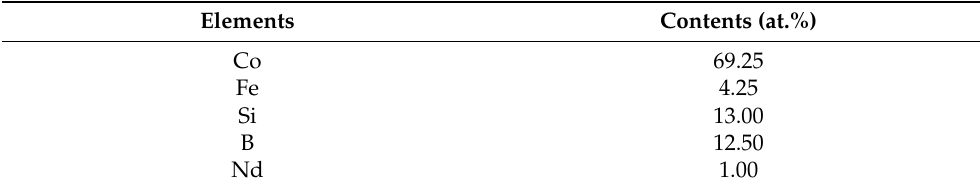
Table 1. The chemical composition of Co-based metallic